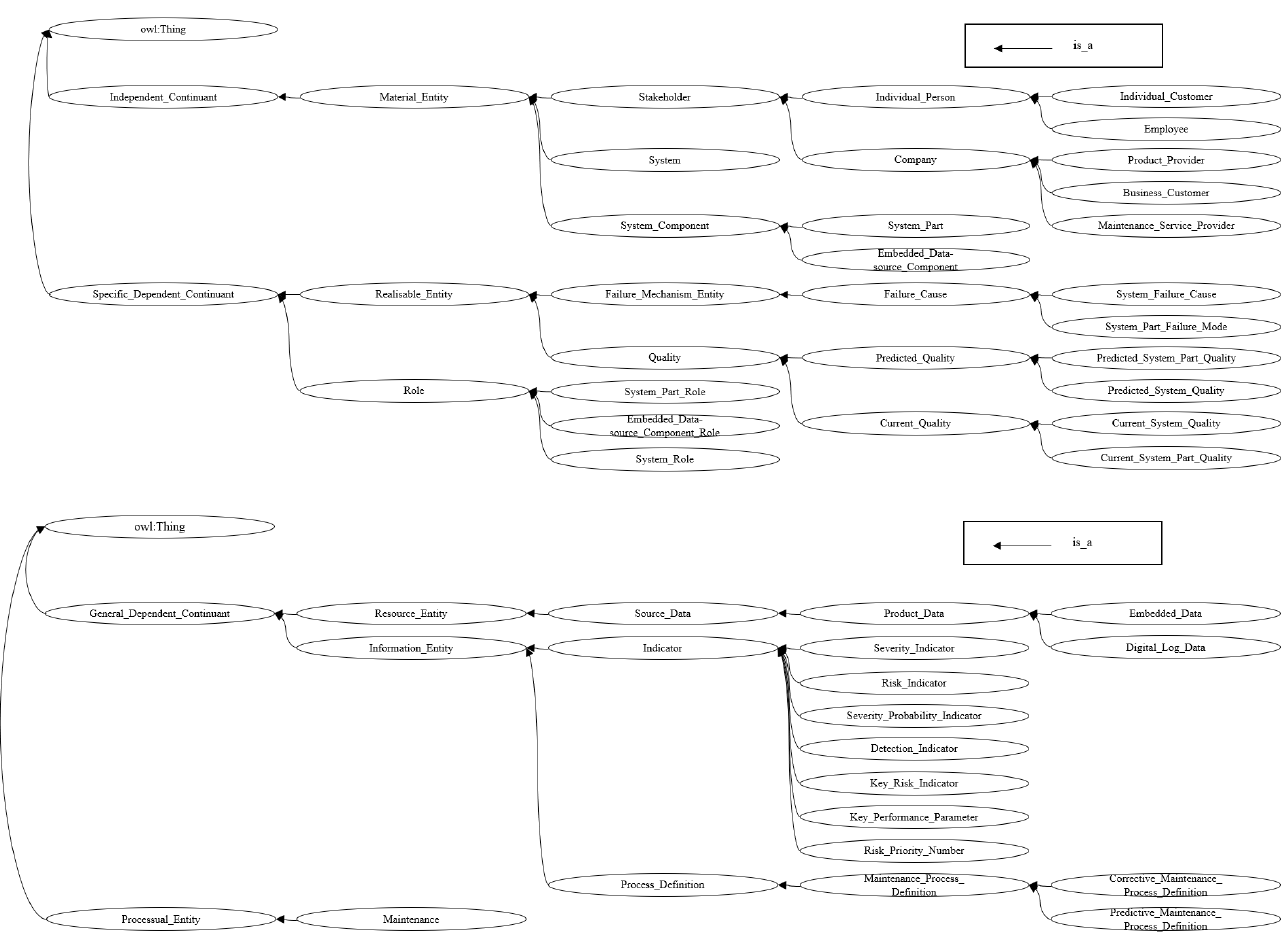
Figure 4. Z-BRE4K semantic model hierarchy.